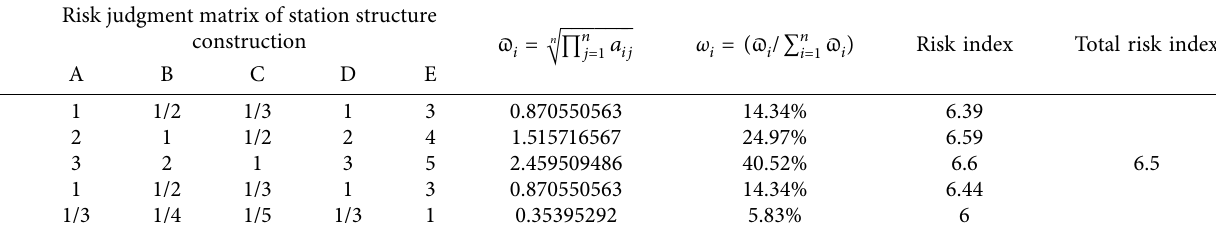
Table 33: Risk judgment matrix of station structure construction.